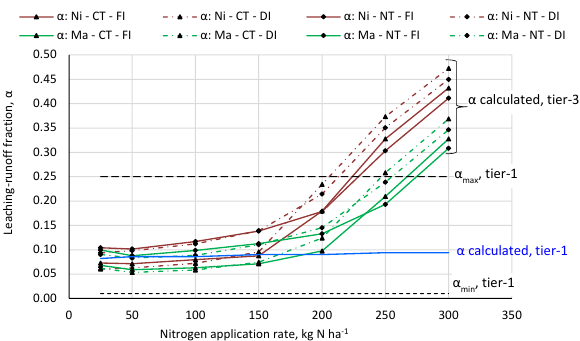
Figure 8. N leaching–runoff fractions α for different management packages and N application rates following from the tier-1 or tier-3 approach. Red lines refer to nitrate (Ni); green lines refer to ma- nure (Ma). Circular markers refer to no-tillage (NT); triangular markers refer to conventional tillage. Dashed lines refer to deficit irrigation (DI); solid lines refer to full irrigation (FI).